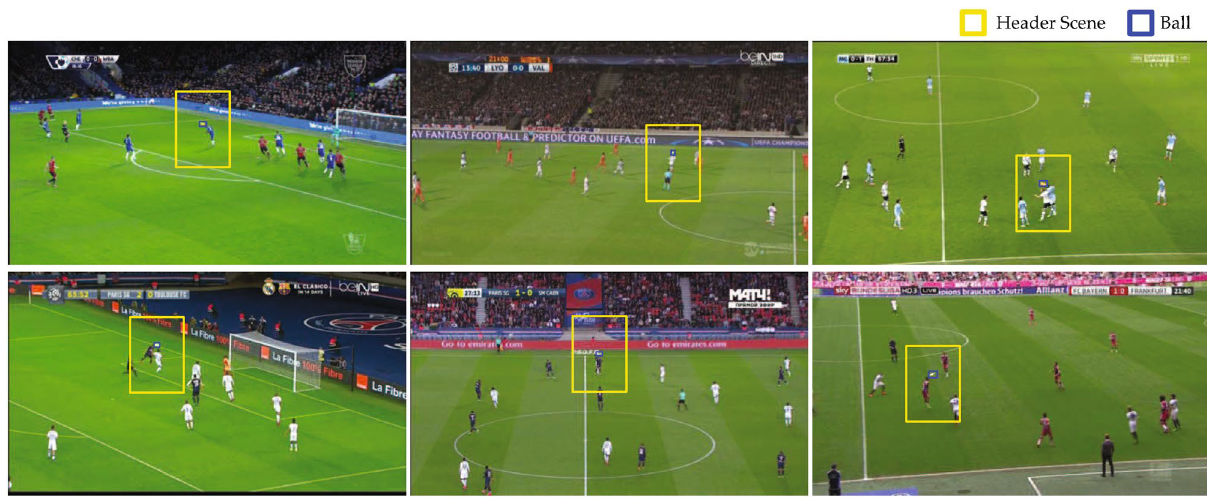
Figure 3. Examples of successful identification of header events. Header events with relatively larger ball size and successful ball detection and tracking were identified